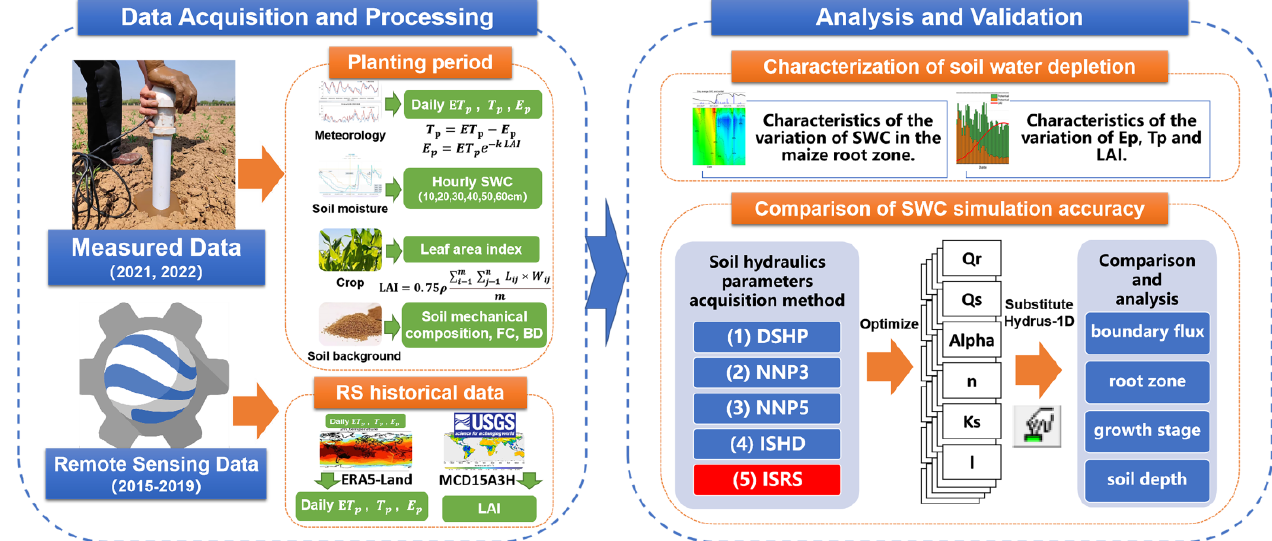
Figure 1. The technical route of this